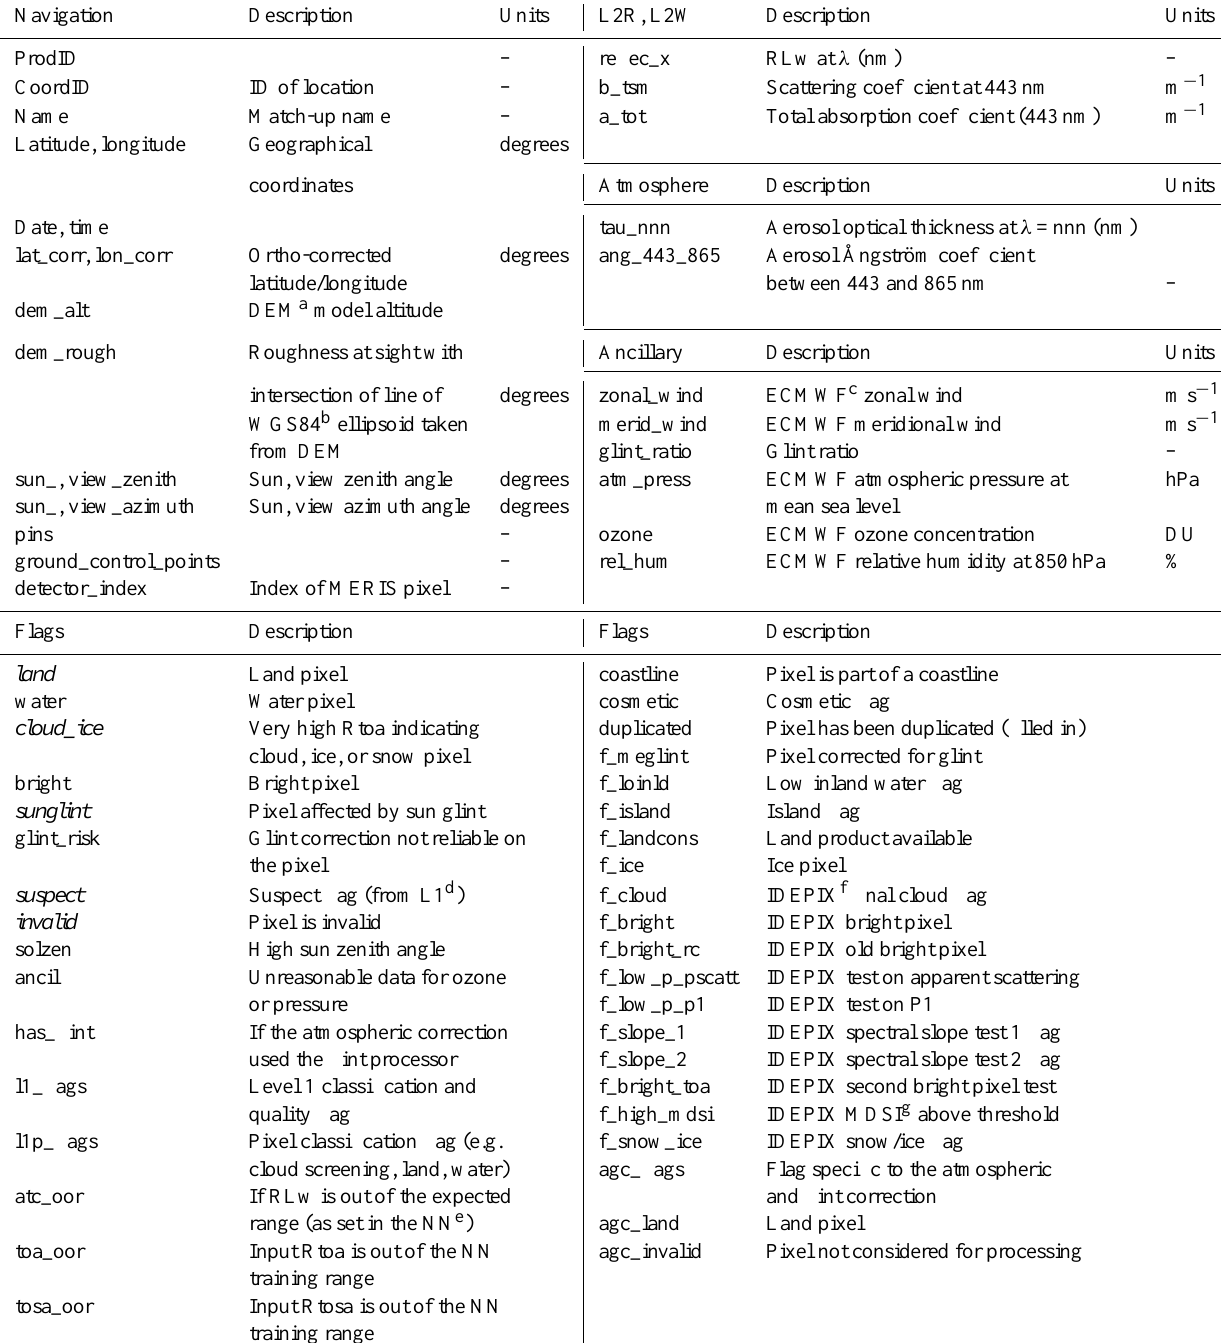
Table 7. The Level 2 products provided the MERIS match-up data set, as a 5 × 5 box around the locations of the match-up field measure- ments. The “critical” flags listed in italic font are associated with pixels being rejected (if the flags are raised) in the post-processed MERIS match-up data